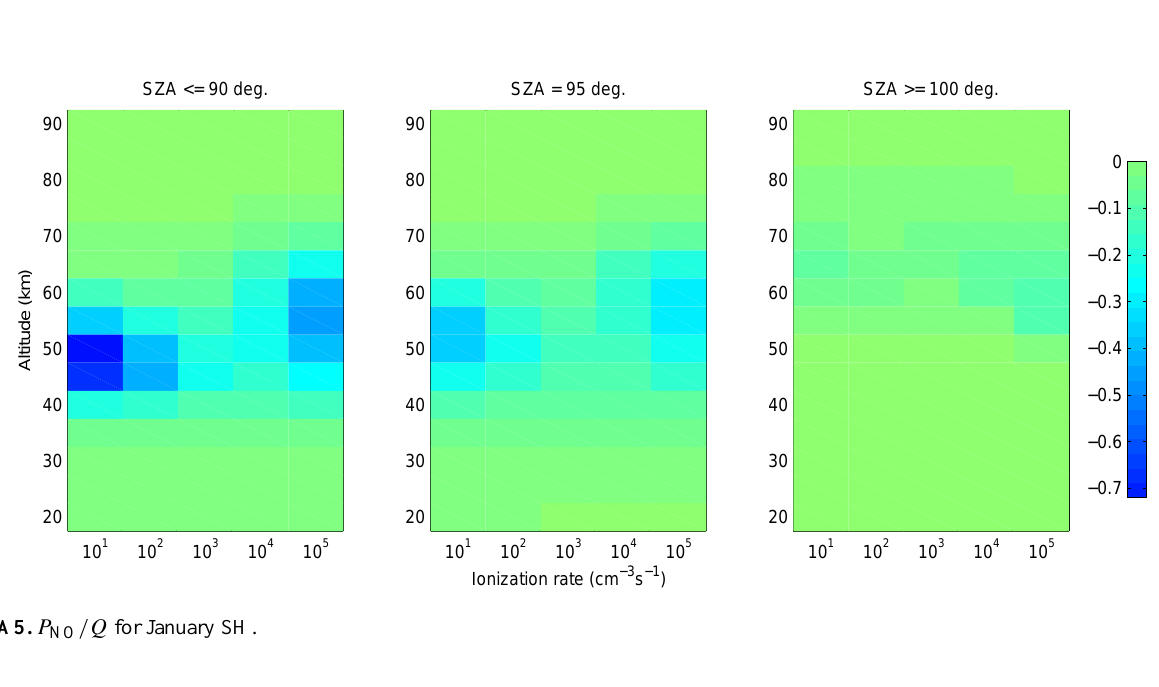
Fig. A5. P NO /Q for January